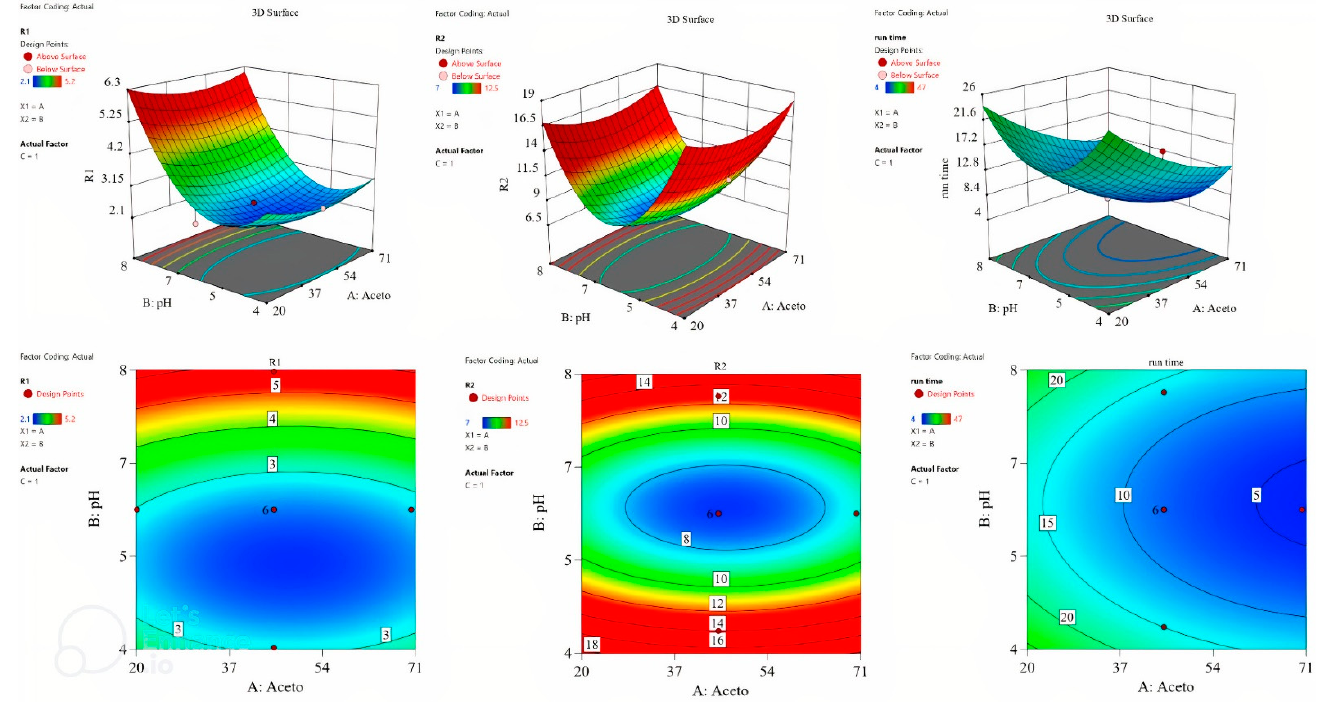
Figure 2. Selected surface and contour plots for the interaction effect of factors on certain re- sponses .